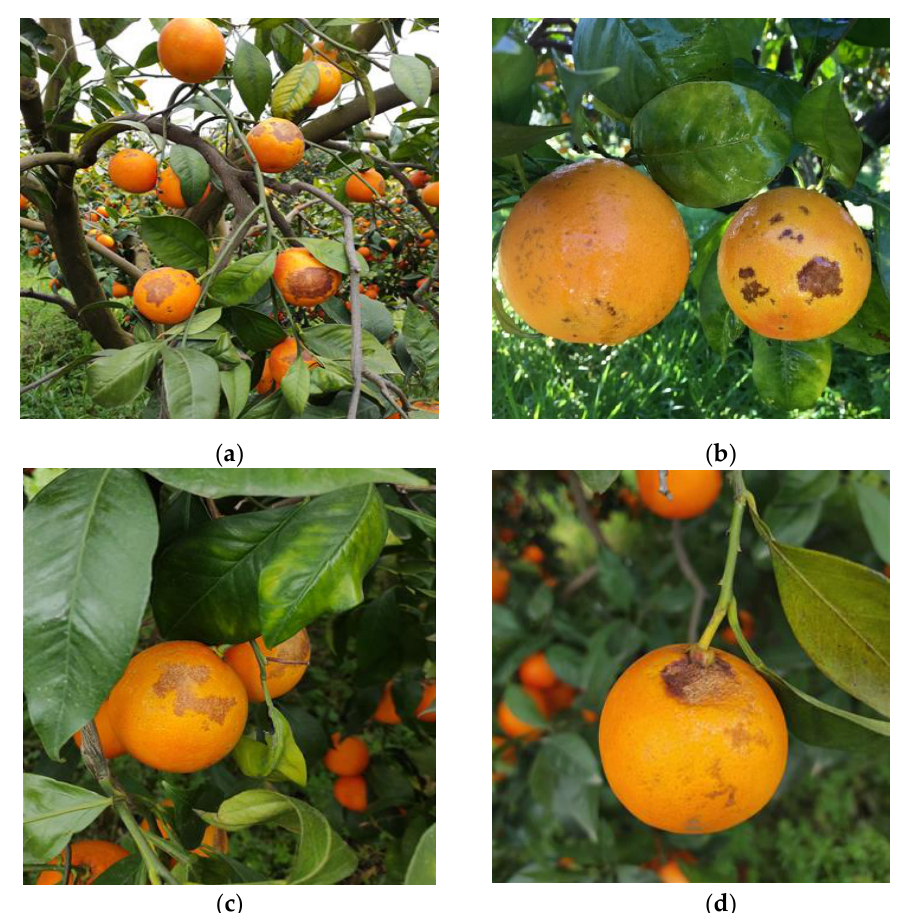
Figure 6. Anthracnose disease symptoms on naturally infected “Tarocco Sciré” fruits: severe an- thracnose fruit spot ( a ); small to large lesions ( b , c ); necrotic lesions at the stem-end of fruit ( d